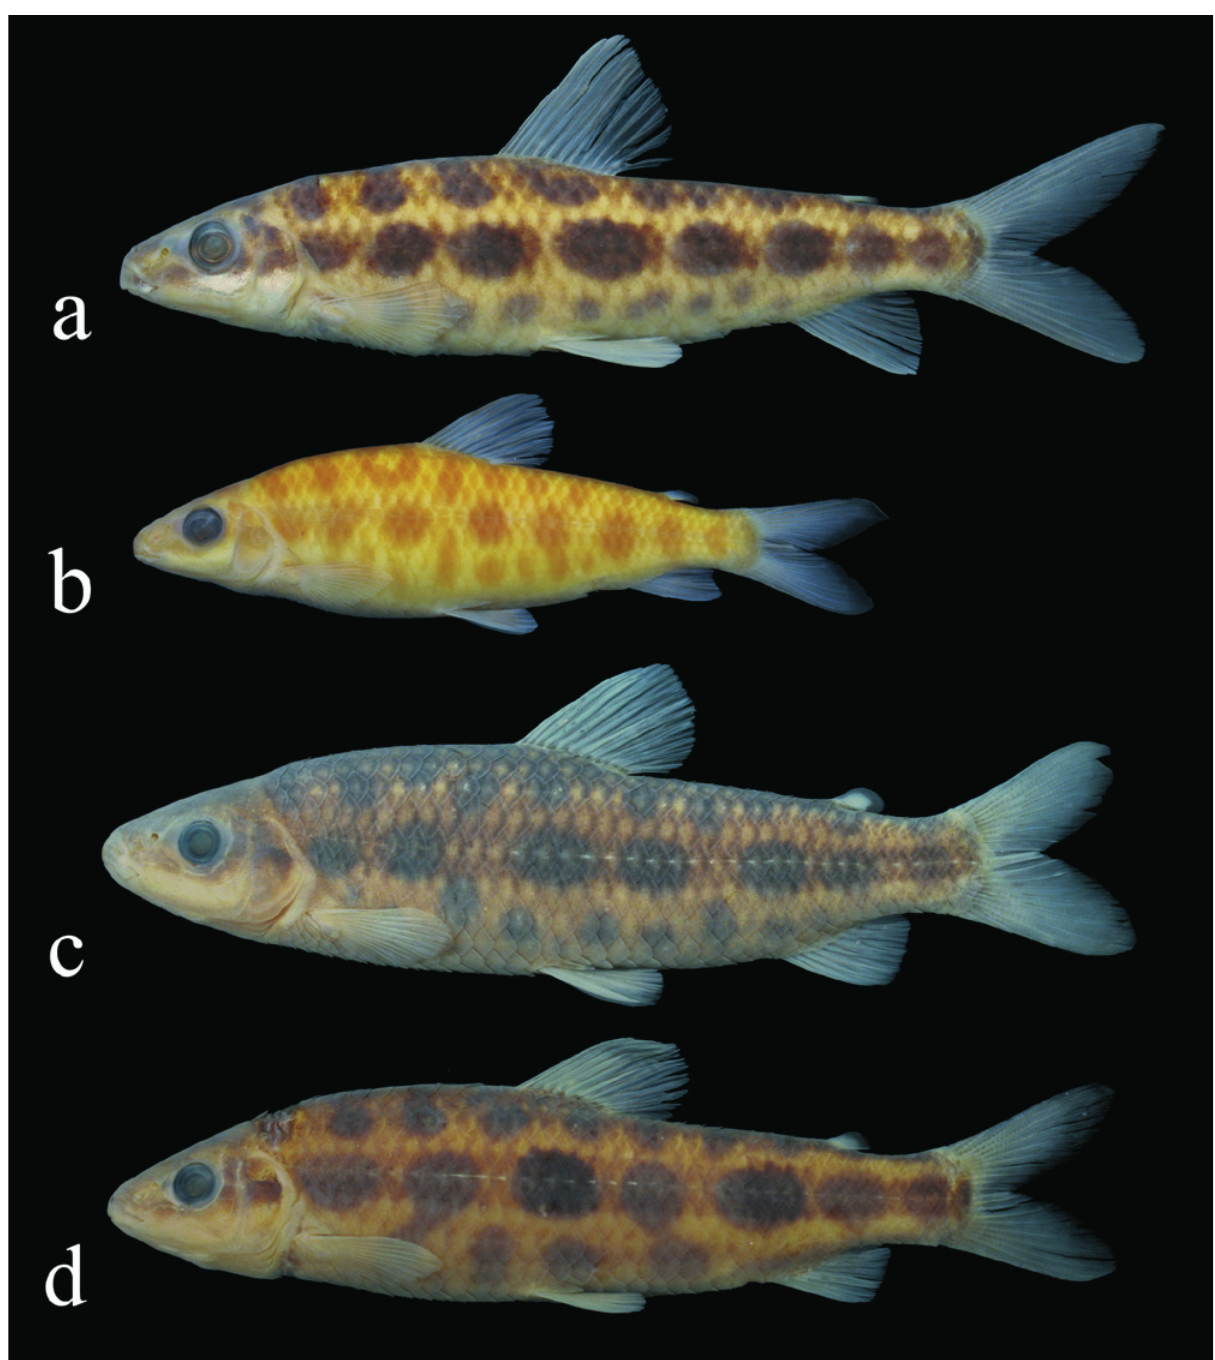
Fig. 7. Leporinus octomaculatus , a – MZUSP 78868, 94.4 mm SL, b – holotype, MZUSP 44794, 68.5 mm SL. L. marcgravii , c – MNRJ 21587, 94.6 mm SL. L. microphthalmus , d – MCP 28230, 94.4 mm